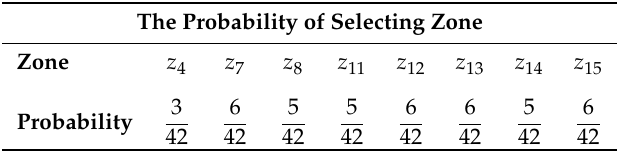
Table 2. The probabilities of selecting border zones in Figure